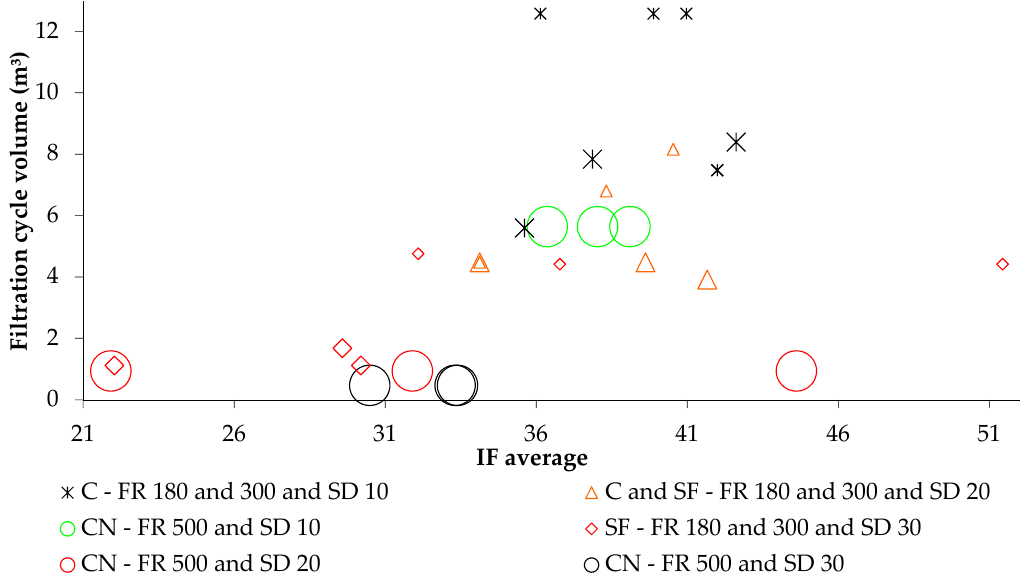
Figure 9. Coagulation diagram with remaining color points in relation to coagulation pH and aluminium sulfate dosage—pilot Water Treatment Plant. Smaller symbols: remaining color > 15 uH, intermediate size symbols: remaining color between 5 uH and 15 uH, and larger symbols: remaining color < 5 uH.